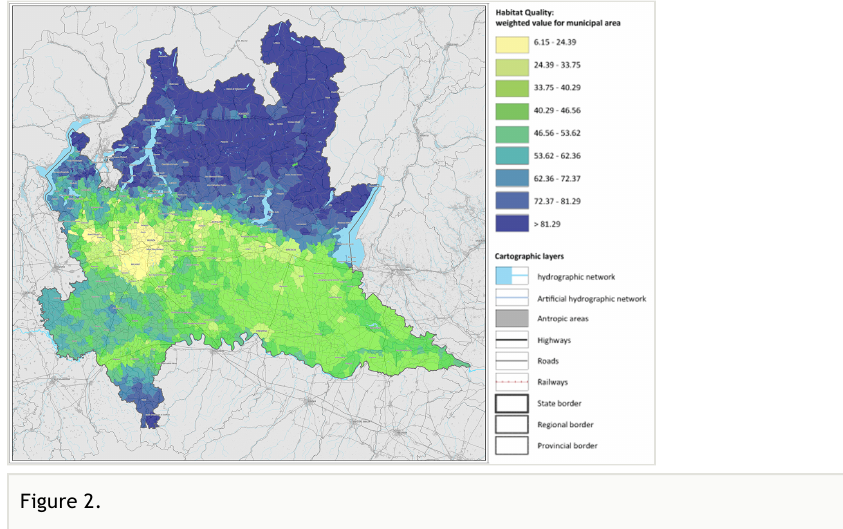
Weighted average of Habitat Quality values per municipality for Lombardy, Italy